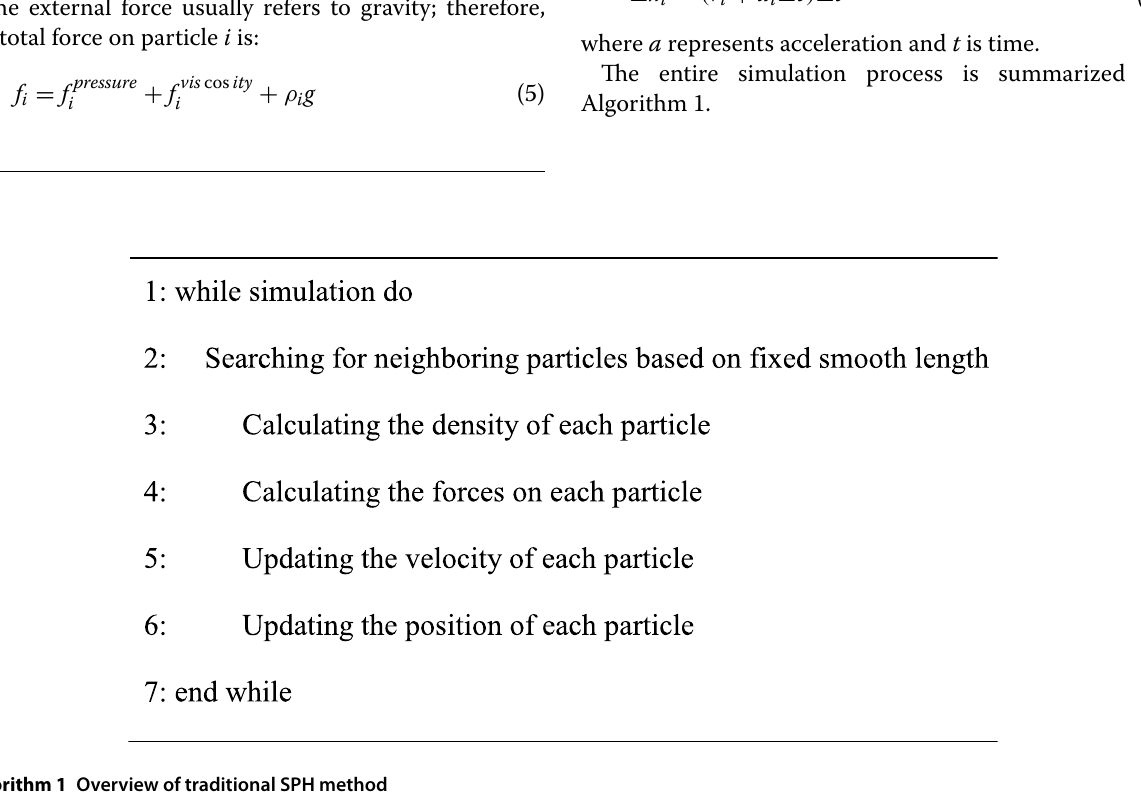
Overview of our